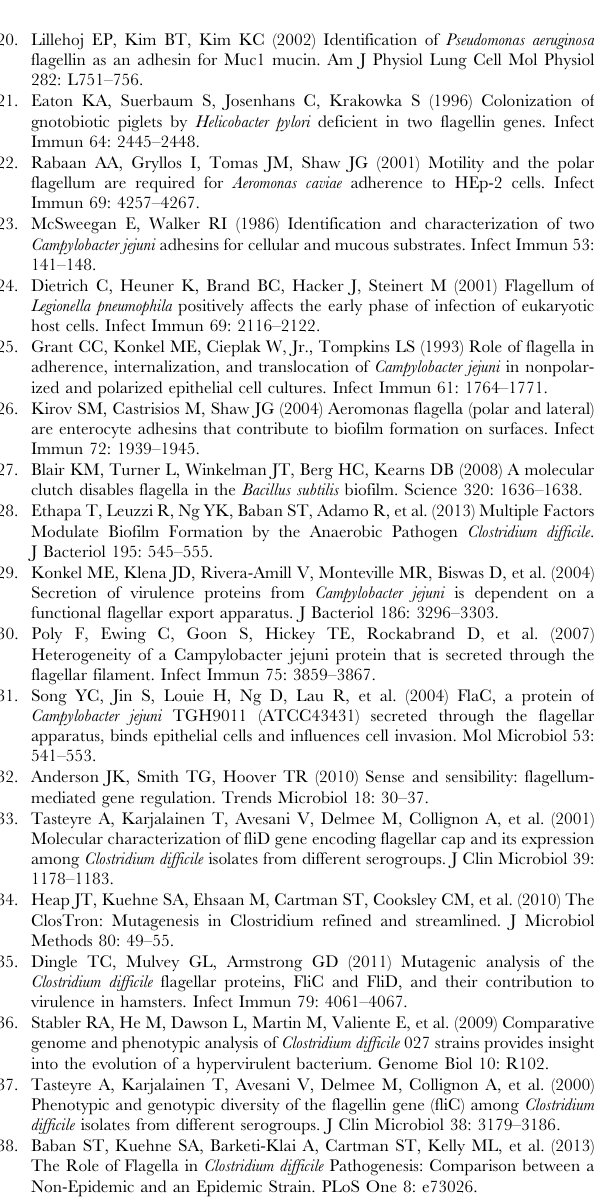
Figure S1 Kinetic of growth of the fliC mutant (FliC) compared to complemented FliC:: fliC mutant and wild-type R20291 (027) in vitro